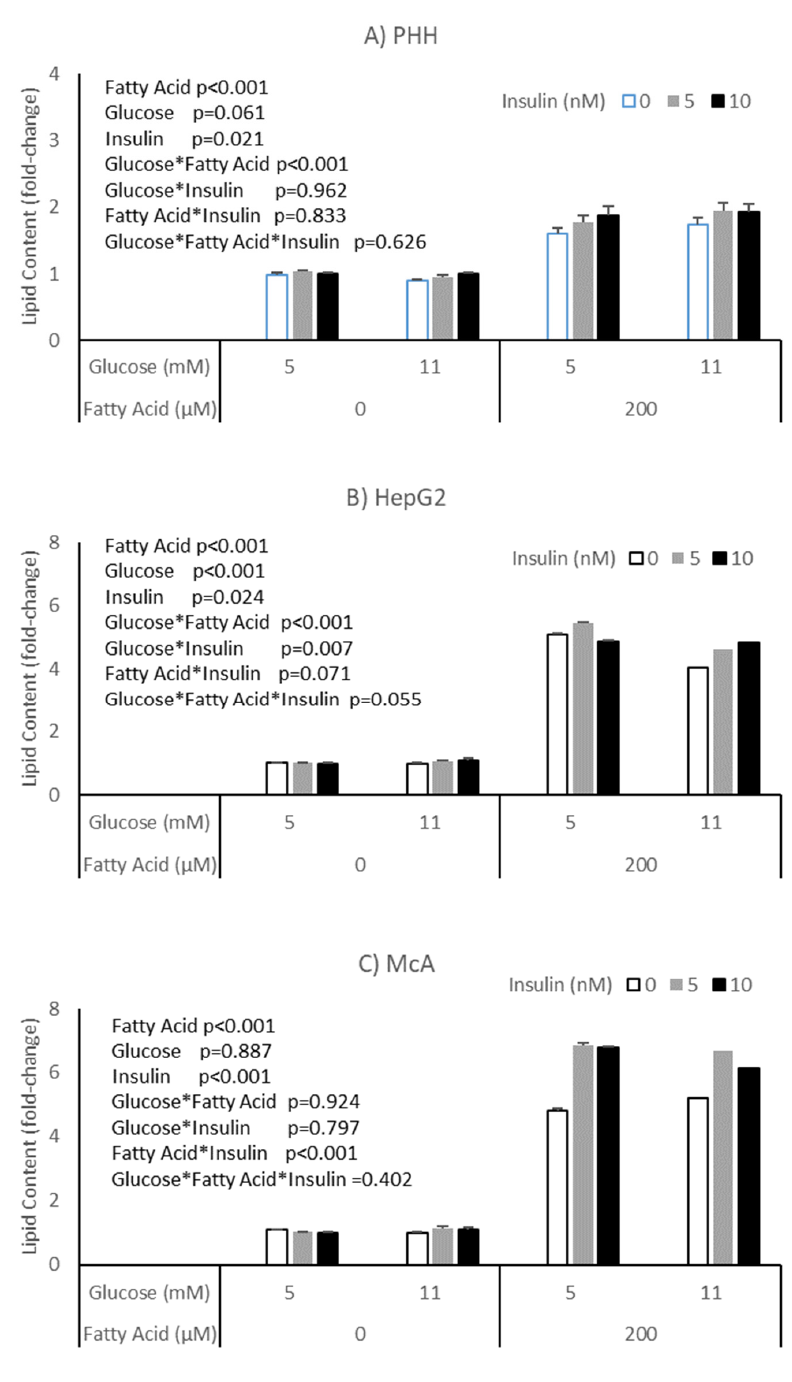
Figure 3. Impact of insulin on the response of different cell types to glucose and fatty acids; ( A ) PHH, ( B ) HepG2, ( C ) McA. Values for PHH represent the mean (±SEM) of data from 3 individual livers (each experiment performed on 2 separate plates with 5 replicates per plate, total replicates = 30). Values for other cell lines represent mean of data from 3 individual experiments (with similar replication as PHH, total replicates = 30/cell type). Data was analysed by 3-way ANOVA (insulin*glucose*fatty acid) with blocking for liver (for PHH) and plate for all cell types.